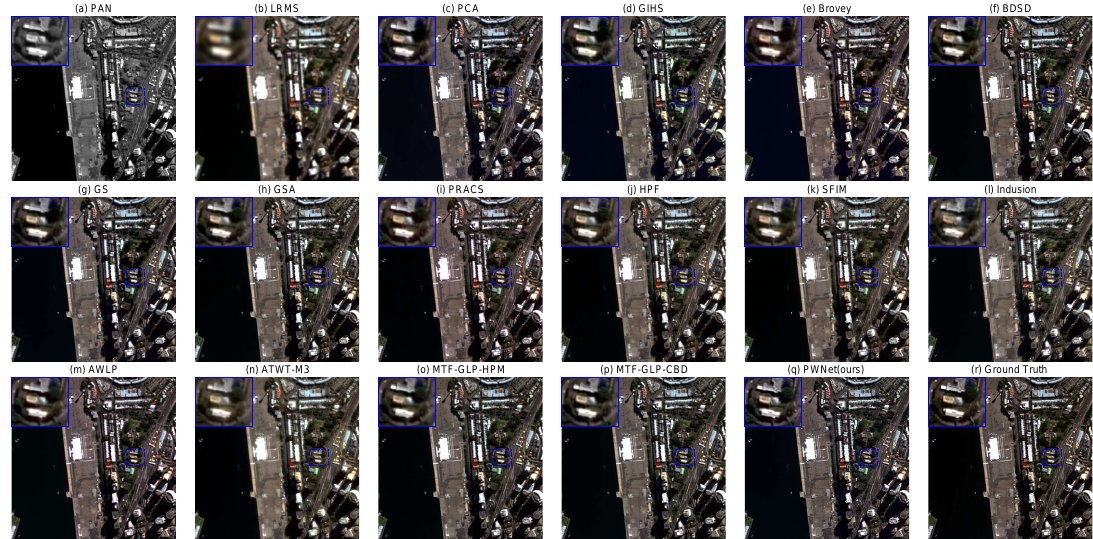
Figure 5. Visual comparison of the CS-based and MRA-based methods and the proposed PWNet method on the WorldView-2 images, ( a ) PAN; ( b ) LRMS; ( c ) PCA; ( d ) GIHS; ( e ) Brovey; ( f ) BDSD; ( g ) GS; ( h ) GSA; ( i ) PRACS; ( j ) HPF; ( k ) SFIM; ( l ) Indusion; ( m ) AWLP; ( n ) ATWT-M3; ( o ) MTF-GLP-HPM; ( p ) MTF-GLP-CBD; ( q ) PWNet (ours); ( r ) Ground